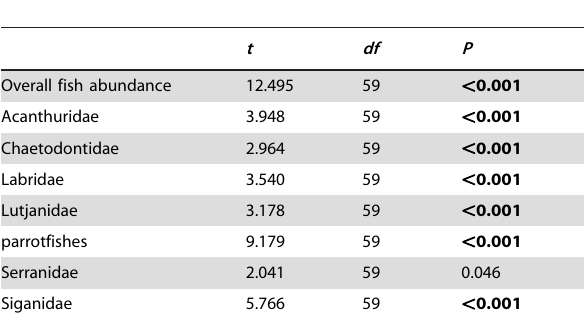
Table 1. Paired t-tests – fixed distance and immediate return.